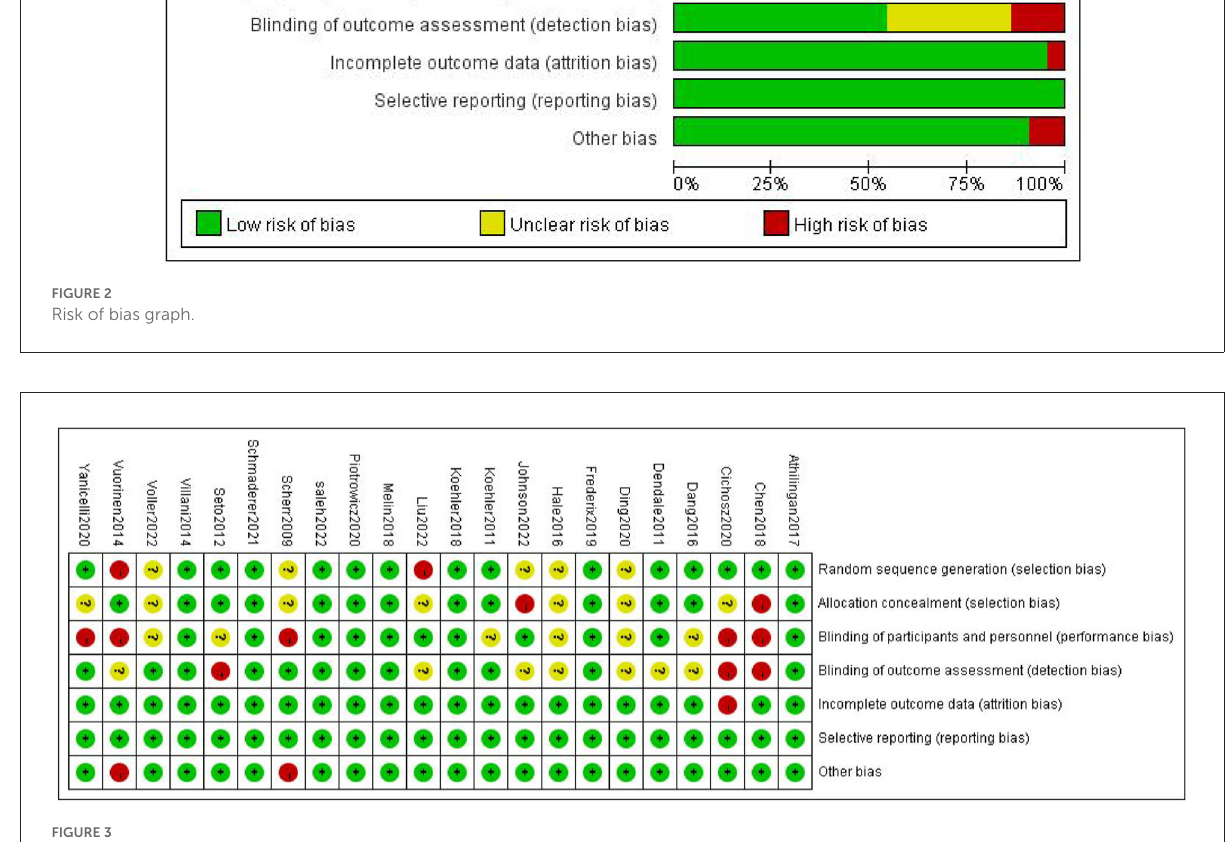
(Figure 8). We found a reduced risk of heart failure-related hospitalizations in patients using the e-health intervention. Subgroup analysis showed no significant difference between the e-health intervention and usual care after grouping, as detailed Figure 9.